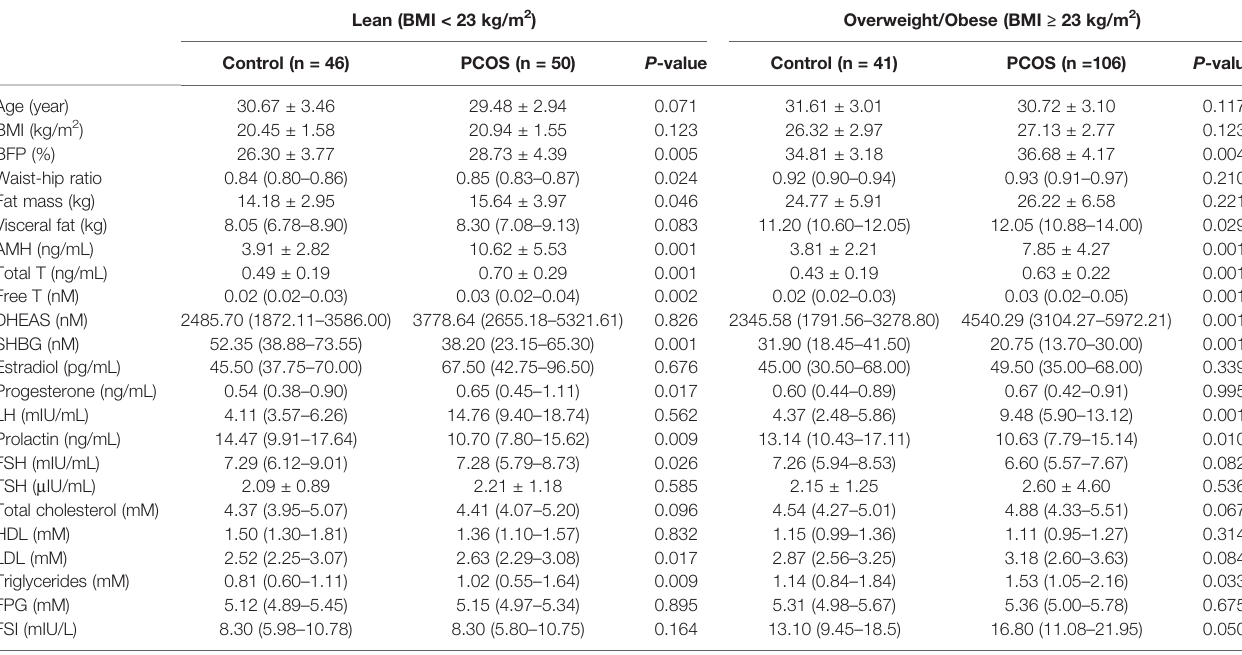
TABLE 1 | Description of the study participants categorized by